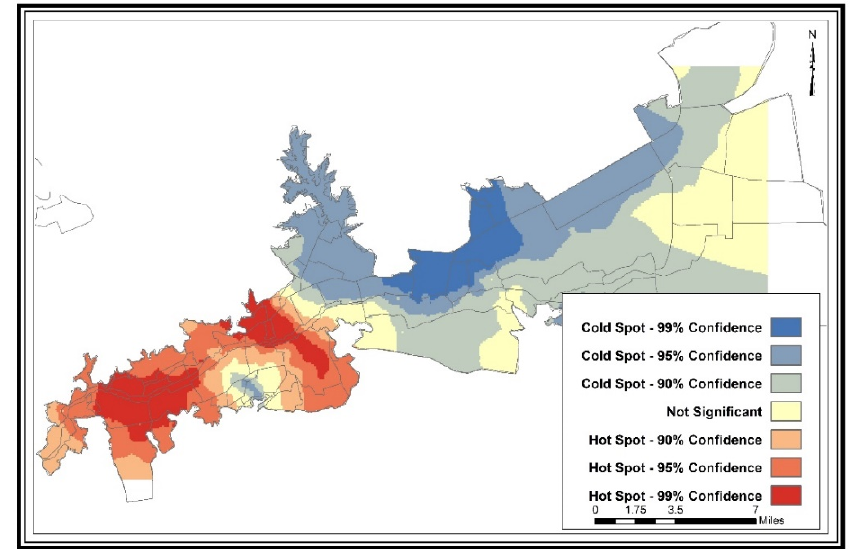
Figure 6. Traffic accident hot spots in the city of Najran.